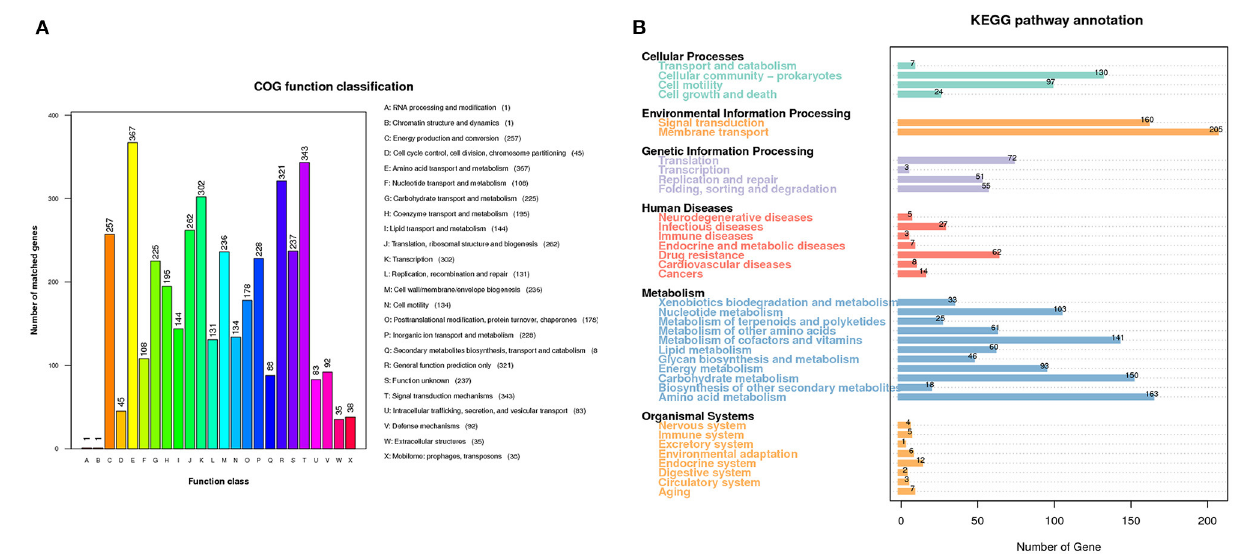
FIGURE 3 | Gene functional analysis of A. hydrophila GD18. (A) Gene functional classifications of A. hydrophila GD18 based on the Clusters of Orthologous Groups (COG) proteins database. (B) Metabolic pathways categories of A. hydrophila GD18 genes based on the KEGG